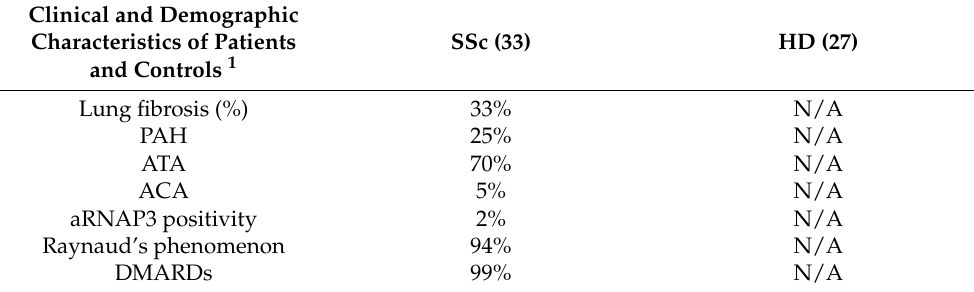
Table 1. Cont. Clinical and Demographic Characteristics of Patients